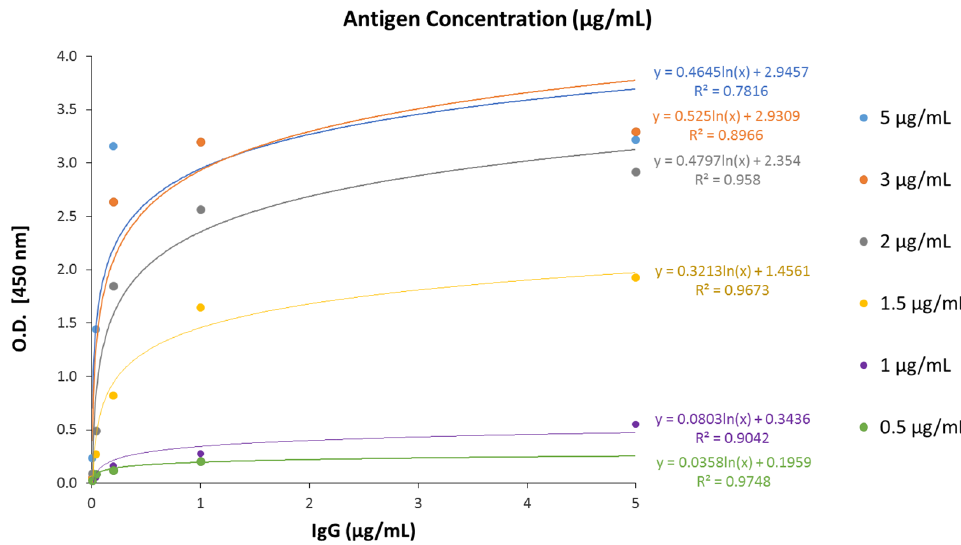
Figure 2. Calibration curves of the optimized ELISA-based serological assay using different anti- gen concentrations. Six concentrations (0.5 µ g/mL, 1 µ g/mL, 1.5 µ g/mL, 2 µ g/mL, 3 µ g/mL, and 5 µ g/mL) of the receptor-binding domain (RBD) of the spike protein of SARS-CoV-2 were used to coat the plates. Then, in each plate, a calibration curve with human IgG (0–5 µ g/mL) was determined. The equation for the adjustment to a logarithmic curve, along with the corresponding coefficient of determination (R 2 , R squared), appears on the right.